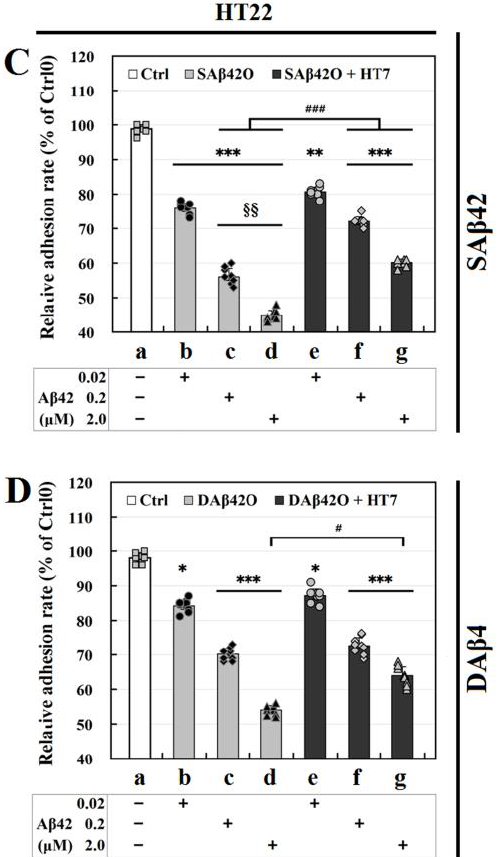
Figure 1. Relative adhesion rates by MTT assay of SH-SY5Y and HT22 cells at 12 h after incubating with three A β 42 species with/without anti-oligomeric A β 42 scFv HT7 antibody. ( A , B ): SH-SY5Y cells, ( C , D ): HT22 cells. Cells in the Ctrl0 (without aspirating shed cells) and Ctrl (aspirating shed cells) groups were cultured normally at 37 ◦ C, 5% CO2 from 12–16 h, and the relative total cell viability in the Ctrl0 group was considered as 100%. Cells in experimental groups were cultured for 12 h in the presence of various SA β 42 and DA β 42 species (final concentration: 0.02–2.0 µ M) with or without anti-oligomeric A β 42 scFv HT7 (or HT6) antibody (final concentration: 2.0 µ M). Differences between the Ctrl0 and Ctrl (white columns) or HT7 (or HT6) (not shown) groups were not significant ( p > 0.05). Asterisks (*) indicate significant differences between experimental and their Ctrl groups (0.01 < * p < 0.05, 0.001 < ** p < 0.01, *** p < 0.001); hash sign (#) indicates significant differences between experimental groups with (black columns) and without (gray columns) HT7 (or HT6) antibody (# p < 0.05, ### p < 0.001); section break (§§) indicates significant differences between SA β 42 and DA β 42 groups. Each experiment was performed in at least triplicate and repeated nine times with different batches of cells. The data met normality of distribution and homogeneity of variance. All data are shown as mean ±